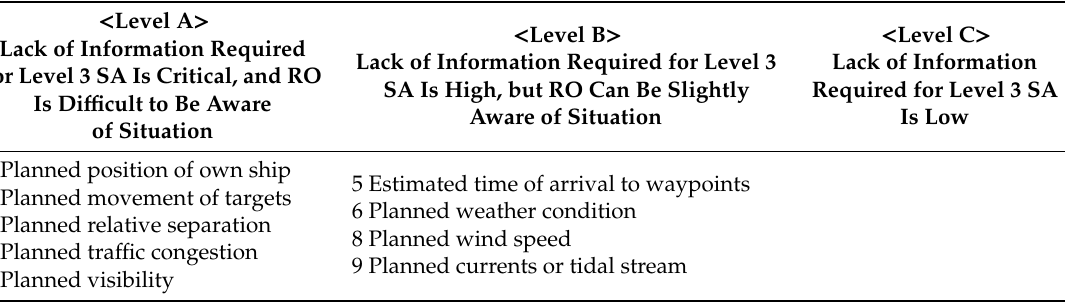
Table 9. Lack of required information for Level 3